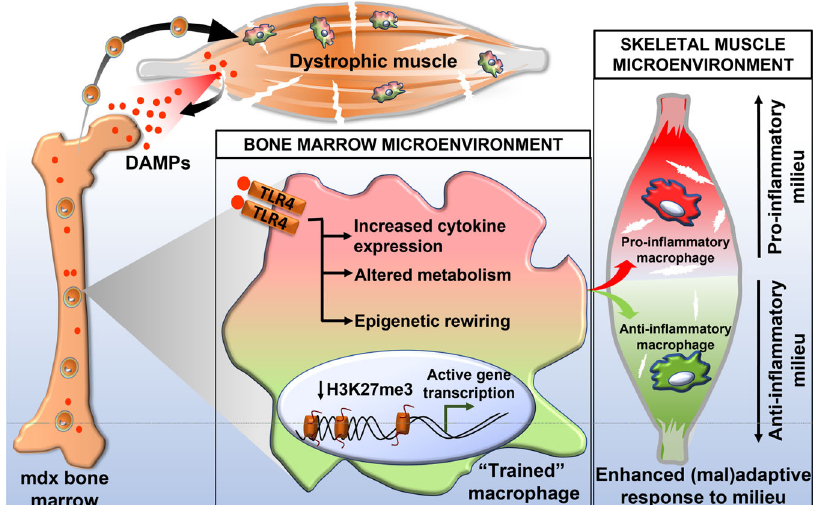
Fig. 8 Model for cross-talk between dystrophic skeletal muscle and bone marrow leading to a reprogrammed macrophage phenotype. According to the model, chronic systemic exposure to damage-associated molecular patterns (DAMPs) acting as ligands for innate immune receptors such as TLR4, induces the hallmark features of trained immunity (cytokine hyperresponsiveness, metabolic alterations, epigenetic rewiring) in macrophage precursor cells residing in the bone marrow. A more open chromatin state for both pro-in fl ammatory and anti-in fl ammatory genes enhances the ability of future macrophages to adopt different phenotypes once the cells home to damaged dystrophic muscle tissue. The ultimate macrophage functional phenotype and impact (adaptive or maladaptive) are dependent on the combination of signals received at the bone marrow level and within the dystrophic muscle